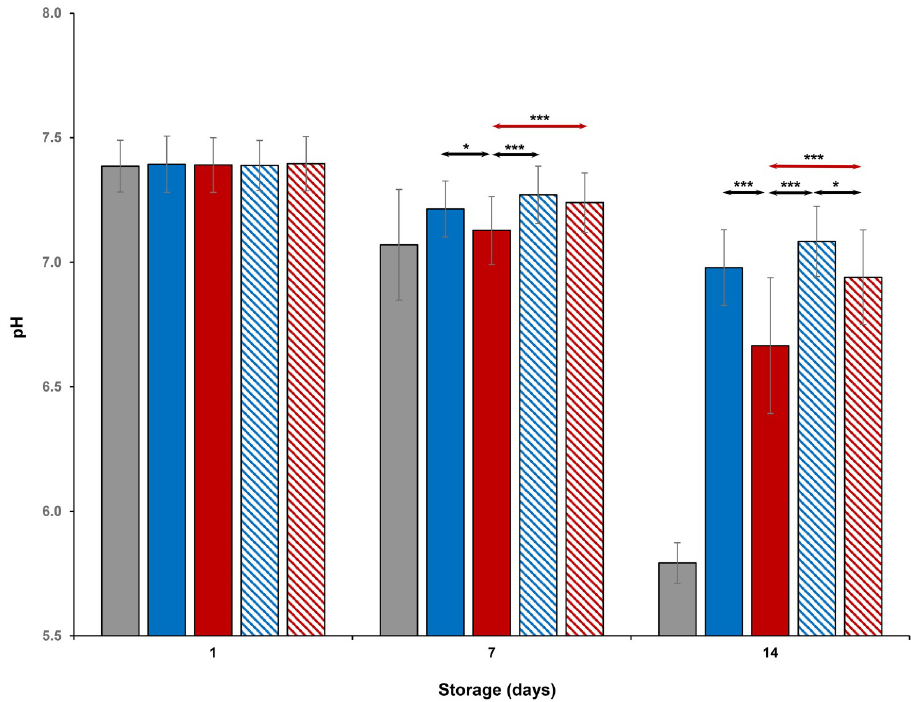
Fig 6. Effects of 14-day storage, temperature and presence of p38MAPK inhibitor on platelet pH levels. Grey bar– platelets stored at room temperature; blue solid bar–cold-stored platelets; red solid bar–thermocycled-stored platelets; blue striped bar–cold-stored + VX-702 platelets; red striped bar–thermocycled-stored + VX-702 platelets. Data represents the mean of 15 experiments with one standard deviation. Arrows represent paired statistical differences; � — p < 0.05, ��� —p <